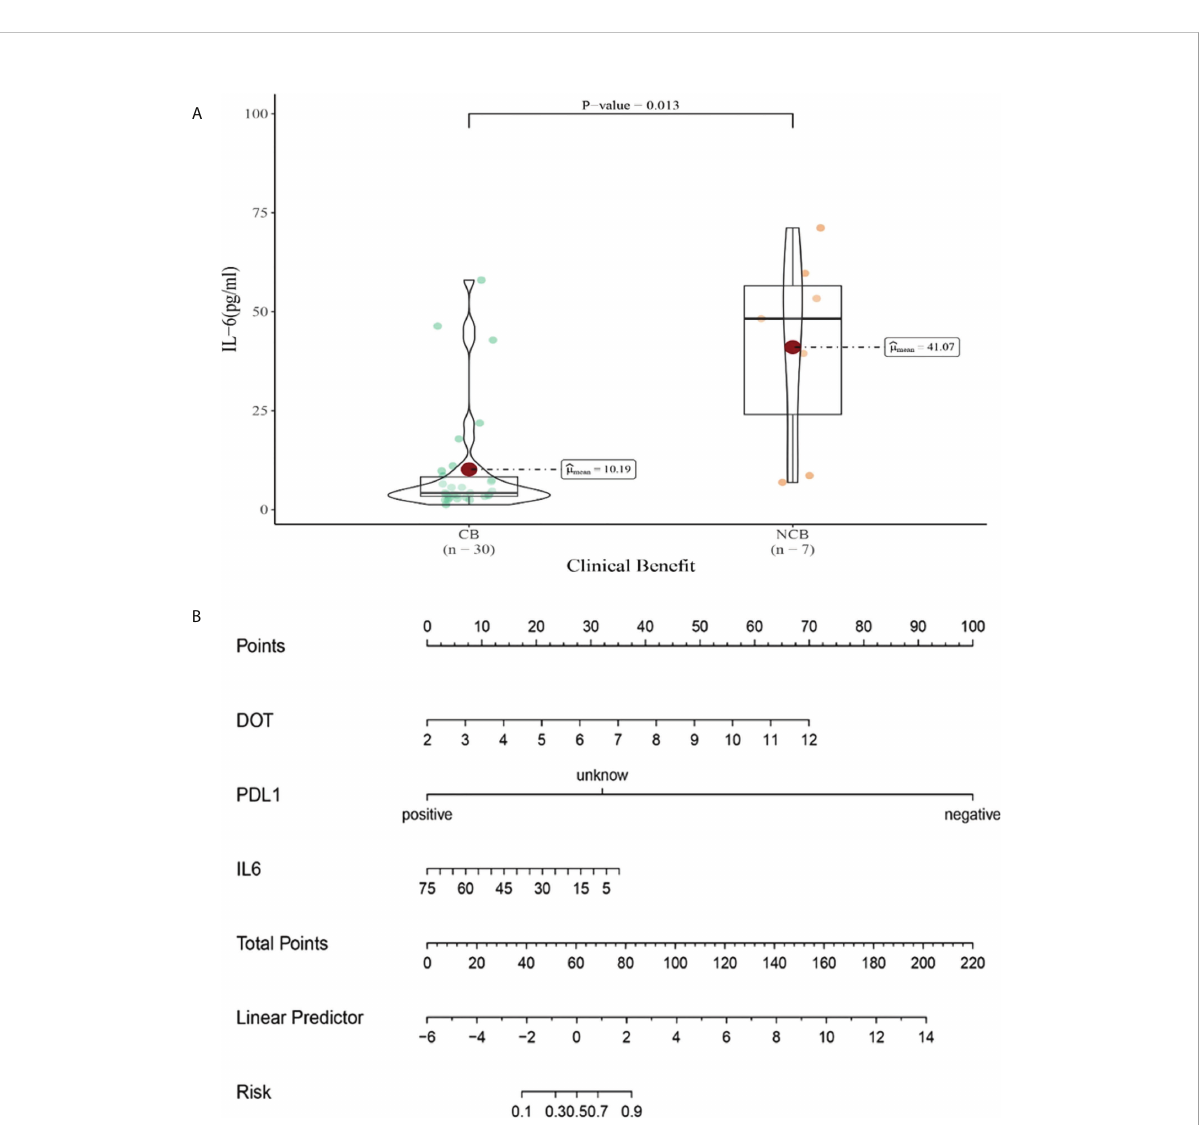
FIGURE 12 (A) Differences in IL-6 levels after the third cycle therapy between CB and UCB; (B) The nomogram based on logistic multivariate